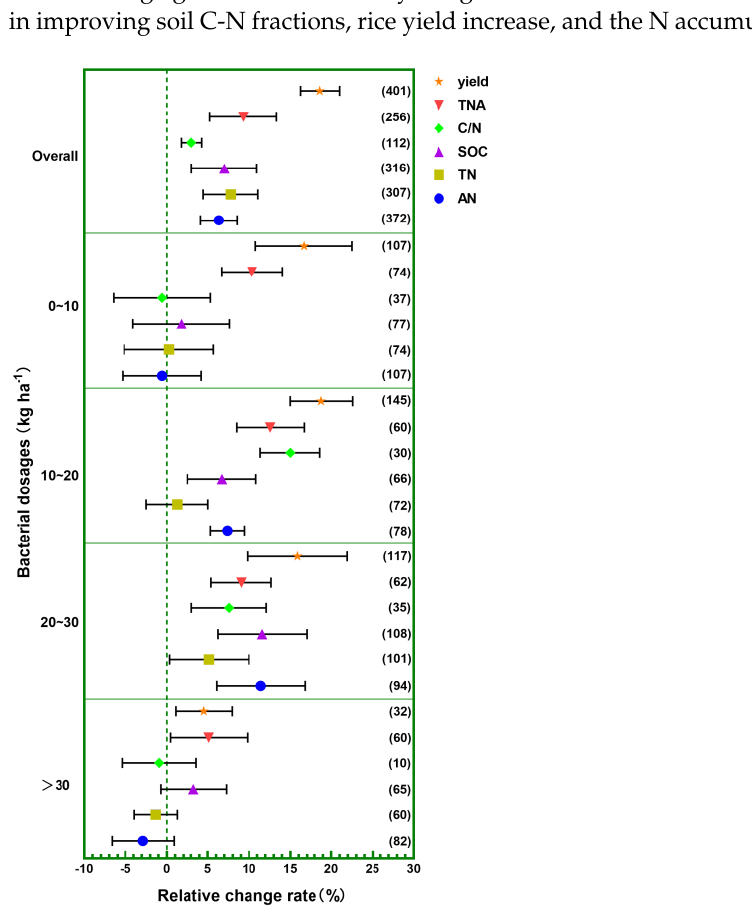
Figure 10. Relative change rates for different bacterial dosages. Description of symbols: AN, soil alkali-hydrolysable nitrogen; TN, soil total nitrogen; SOC, soil organic matter; and TNA, total N accumulation. Numbers in parentheses represent the effect value (lnR).